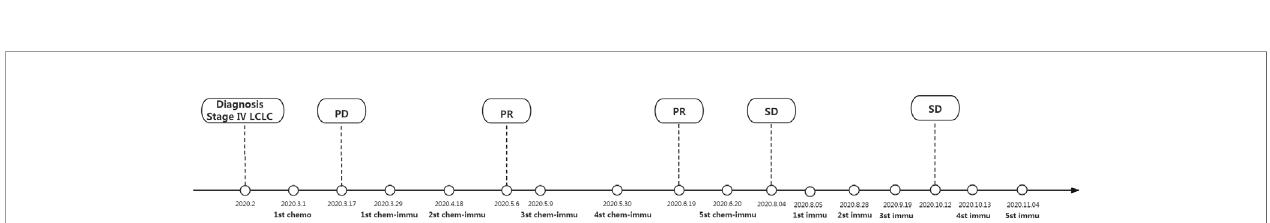
FIGURE 2 | Time line and therapeutic regime. LCLC, large cell lung cancer; PR, partial response; PD, progressive disease; chemo, chemotherapy of pemetrexed (800 mg/kg, d1) plus lobaplatin (50 mg, d1) and endosta (30 mg/day, 7days); chemo-immu, chemo-immunotherapy of pembrolizumab (200 mg/kg, d1) combining paclitaxel (400 mg/kg, d1) plus cisplatin (120 mg/kg, d2); immu, immunotherapy monotherapy of pembrolizumab (200 mg/kg, d1). This patient was diagnosed as stage IV (cT4N3M1) LCLC for diseased lungs and multiple metastases or lymph node enlargements based on fi beroptic bronchoscopy and CT imaging, together with pathological fi ndings showing poor differentiated large cell tumor. Due to no driver gene mutations, this patient was initiated with classical chemotherapy. After disease progression, he turned to chemo-immunotherapy regime for a positive PD-L1 expression (TPS 5 – 10%). Compared with the baseline fi ndings of fi beroptic bronchoscopy and CT imaging, this advanced LCLC patient bene fi ted from chemo-immunotherapy and the following maintenance immunotherapy monotherapy when rapidly progressed after classical chemotherapy till November